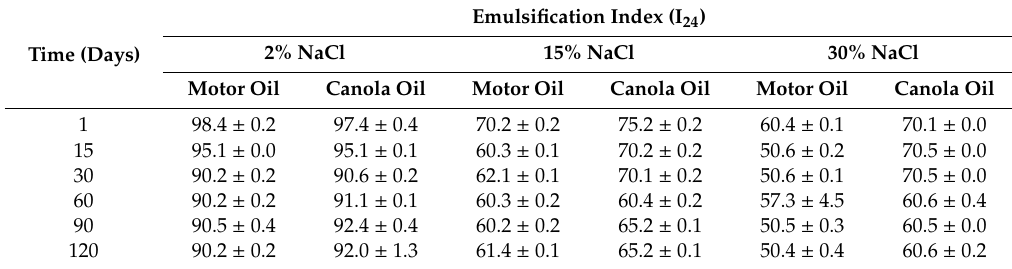
Table6. Motoroilandcanolaoilemulsificationstabilityover120daysondi ff erentsalinityconcentrations Table 6. Motor oil and canola oil emulsification stability over 120 days on different salinity (data expressed as mean ± standard concentrations (data expressed as mean ± standard deviation).